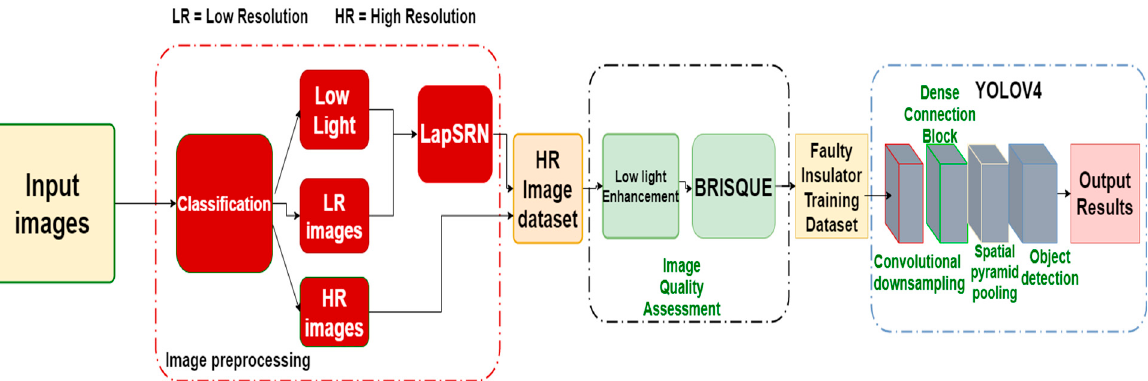
Figure 3. Workflow for the proposed methodology.